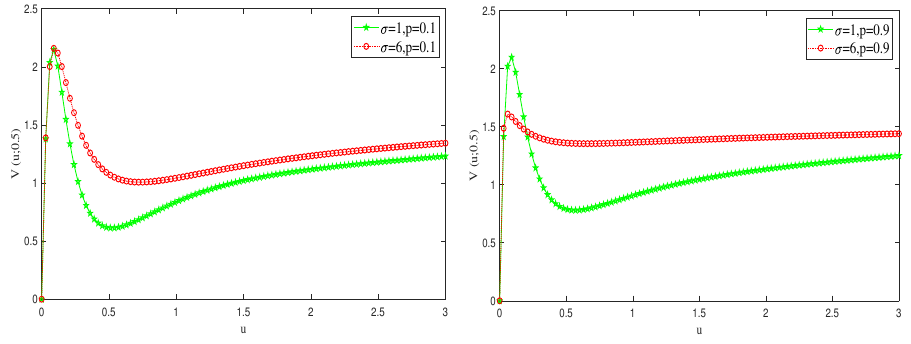
, ˆ β = 1 , ˆ d = π , σ = 6 and p = 0.1, p = 0.9. 2 2 4